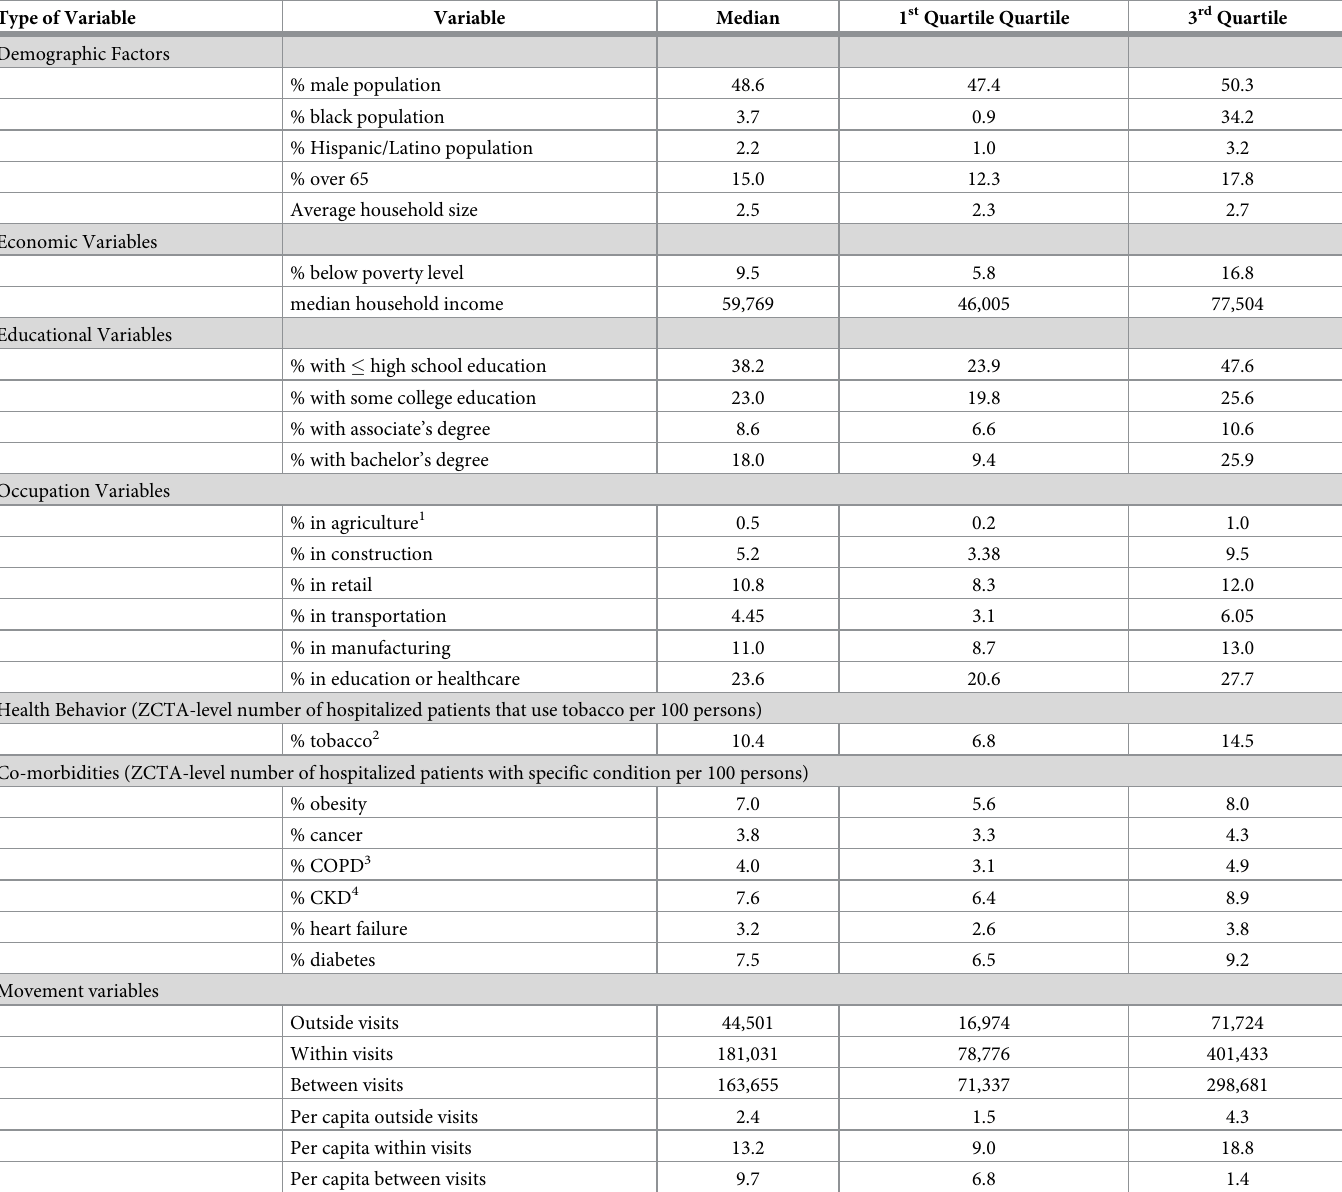
Table 1. Summary statistics of ZCTA-level potential predictors of COVID-19 risk in the Greater St. Louis Area, Missouri